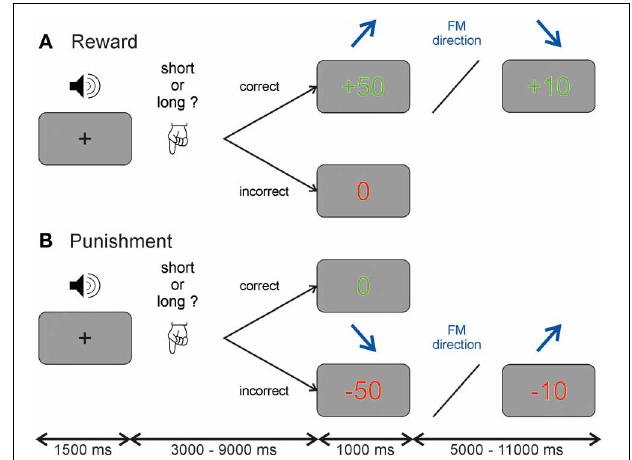
FIGURE 1 | Auditory discrimination paradigm. Each participant performed a reward and a punishment session on two occasions. Each trial started with a frequency modulated tone and participants had to judge whether the tone was longer or shorter than 600ms. Depending on the session participants received either (A) a reward of 10 or 50 Euro cent for correct answers and no money (indicated by a 0) for incorrect answers or (B) no money (indicated by a 0) for correct answers and a subtraction of either 10 or 50 Euro cent from a starting value of 25 Euros for incorrect answers. The value of the reinforcement depended in both cases on the direction of the frequency modulated tone which was unknown to the participant and randomized across